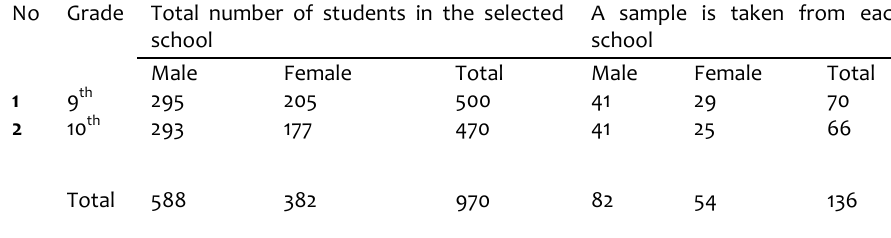
Table 1: Sample students from the sample